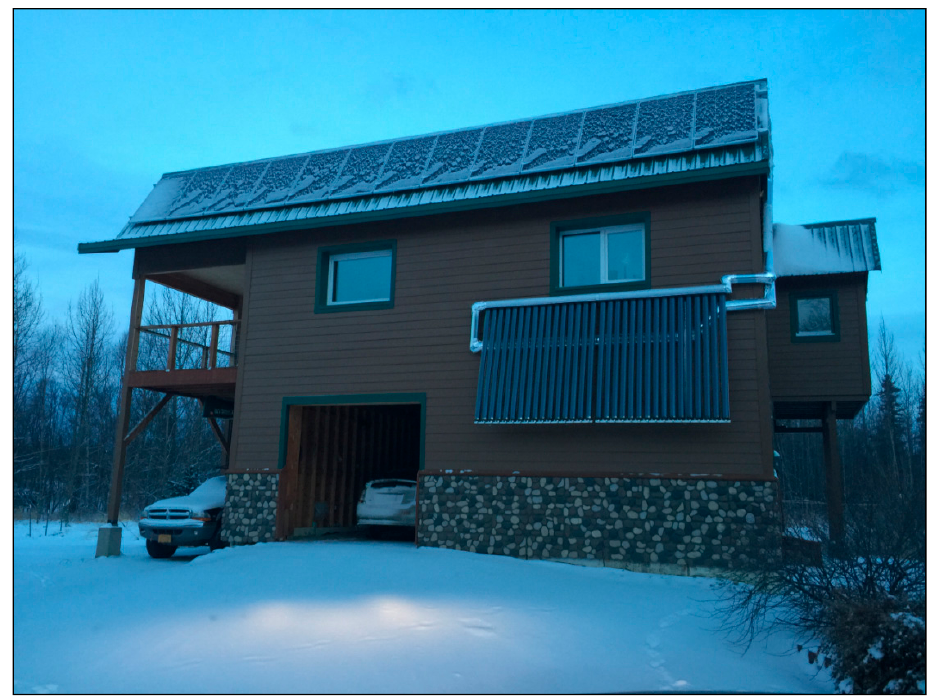
Figure 1. The house in the city Palmer, Alaska (61.6° N, 149.1° W) used for the experiment.